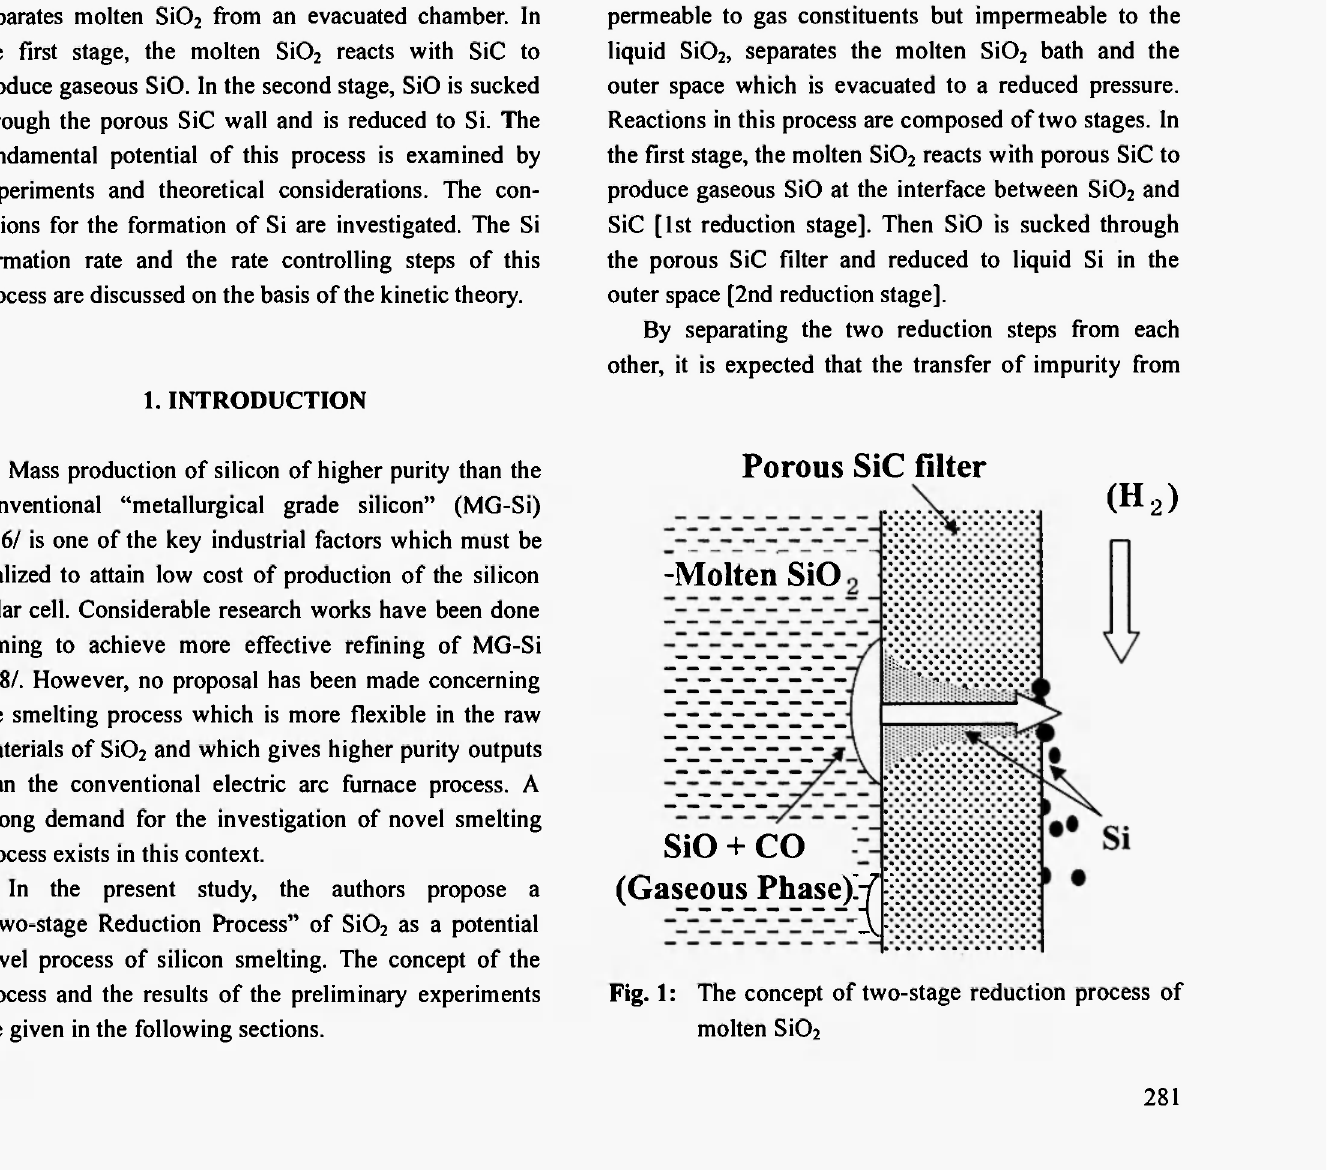
Fig. 1 : The concept of two-stage reduction process of molten Si0